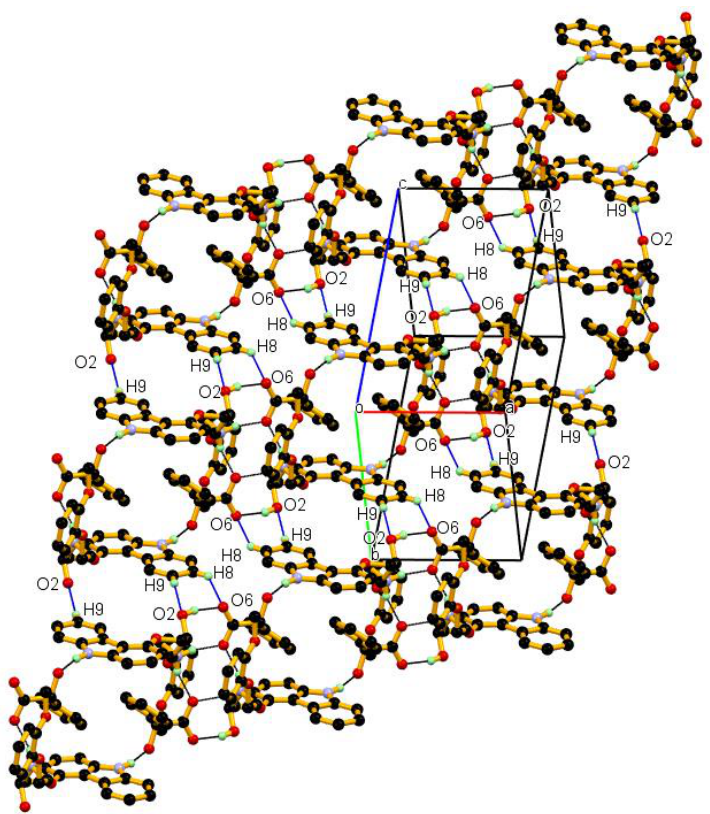
Figure 6. Packing of 1D-dimeric chain, via weak C8–H8 ··· O6 and dimeric C9–H9 ··· O2 hydrogen bonding interaction along the c -axis. Blue dotted lines indicate the association of neighboring chains.